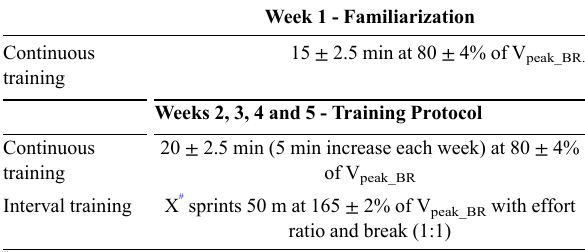
Table 1 - Continuous and interval training of BR.